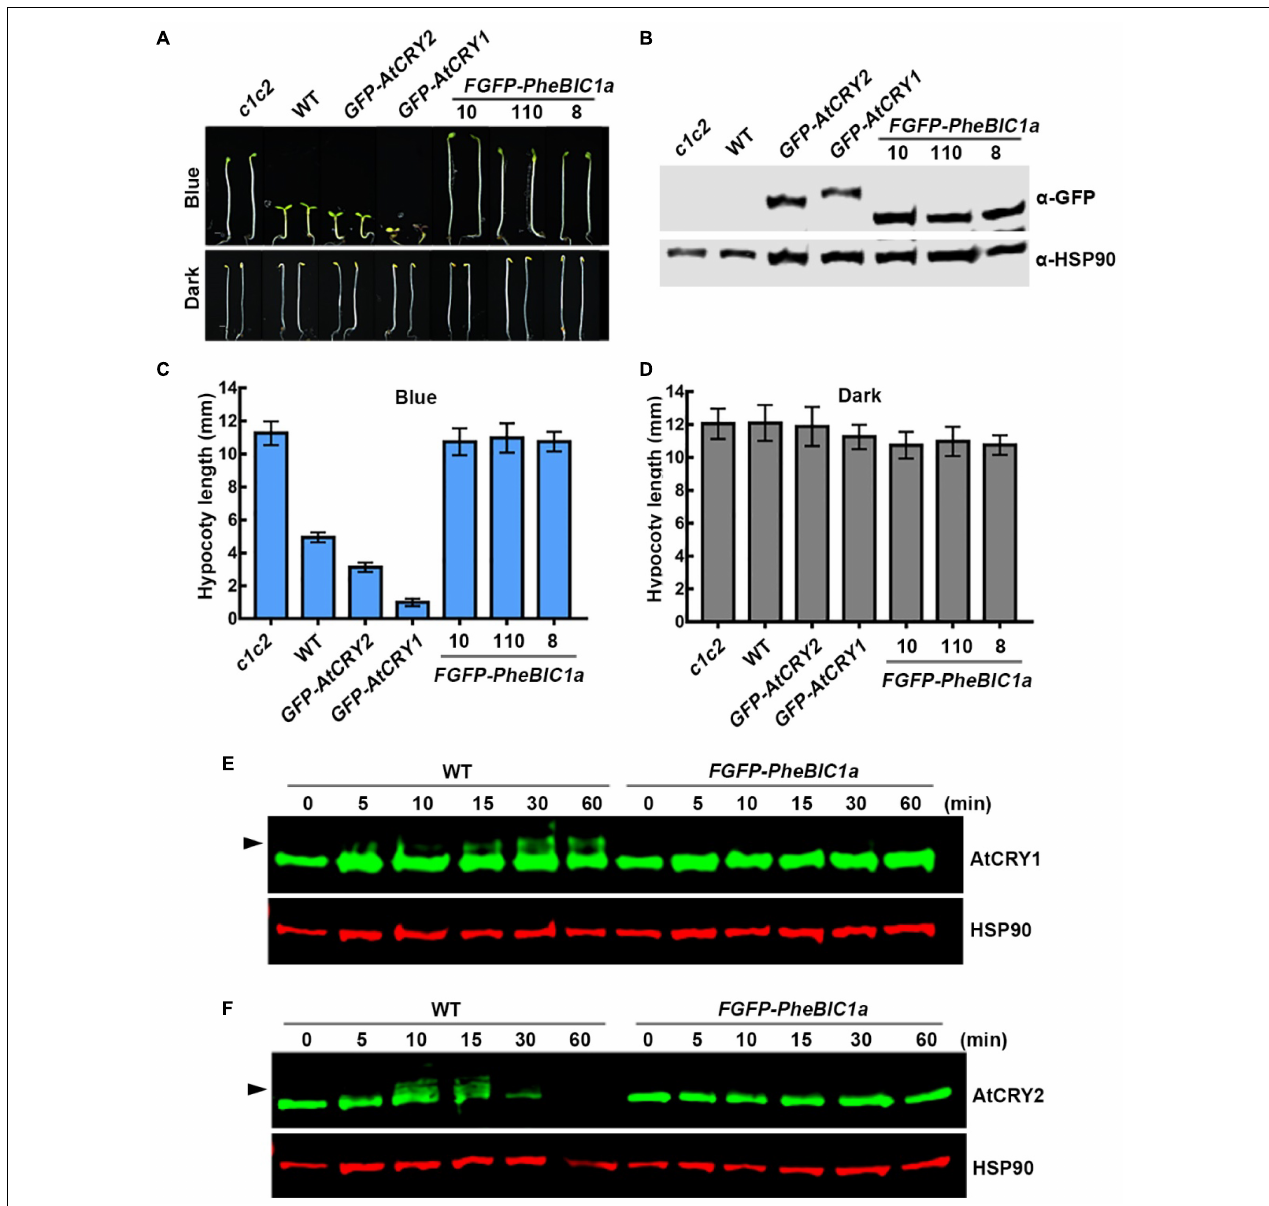
FIGURE 5 | Bamboo PheBIC1 promotes hypocotyl elongation in blue light. (A) Images of 5-day-old Arabidopsis seedings grown under continuous blue light (10 µ molm − 2 s − 1 ) or darkness. Scale bar, 1 mm. (B) Immunoblots showing the expression of FGFP-PheBIC1a of seedlings shown in (A) . PheBIC1 and HSP90 were detected with anti-GFP antibody or anti-HSP90 antibody, respectively. HSP90 is used as a loading control. (C,D) Measurements of hypocotyl length of seedlings shown in (A) , (mean ± SD, n ≥ 20). (E,F) Immunoblots showing the phosphorylation and degradation of endogenous Arabidopsis CRY1 and CRY2 in the wild-type or FGFP-PheBIC1a transgenic Arabidopsis . 7-day-old etiolated seedlings were irradiated with 30 µ molm − 2 s − 1 of blue light for the indicated time. Anti-AtCRY1, anti-AtCRY2 and anti-HSP90 antibodies were used to probe AtCRY1, AtCRY2 or HSP90. HSP90 is used as a loading